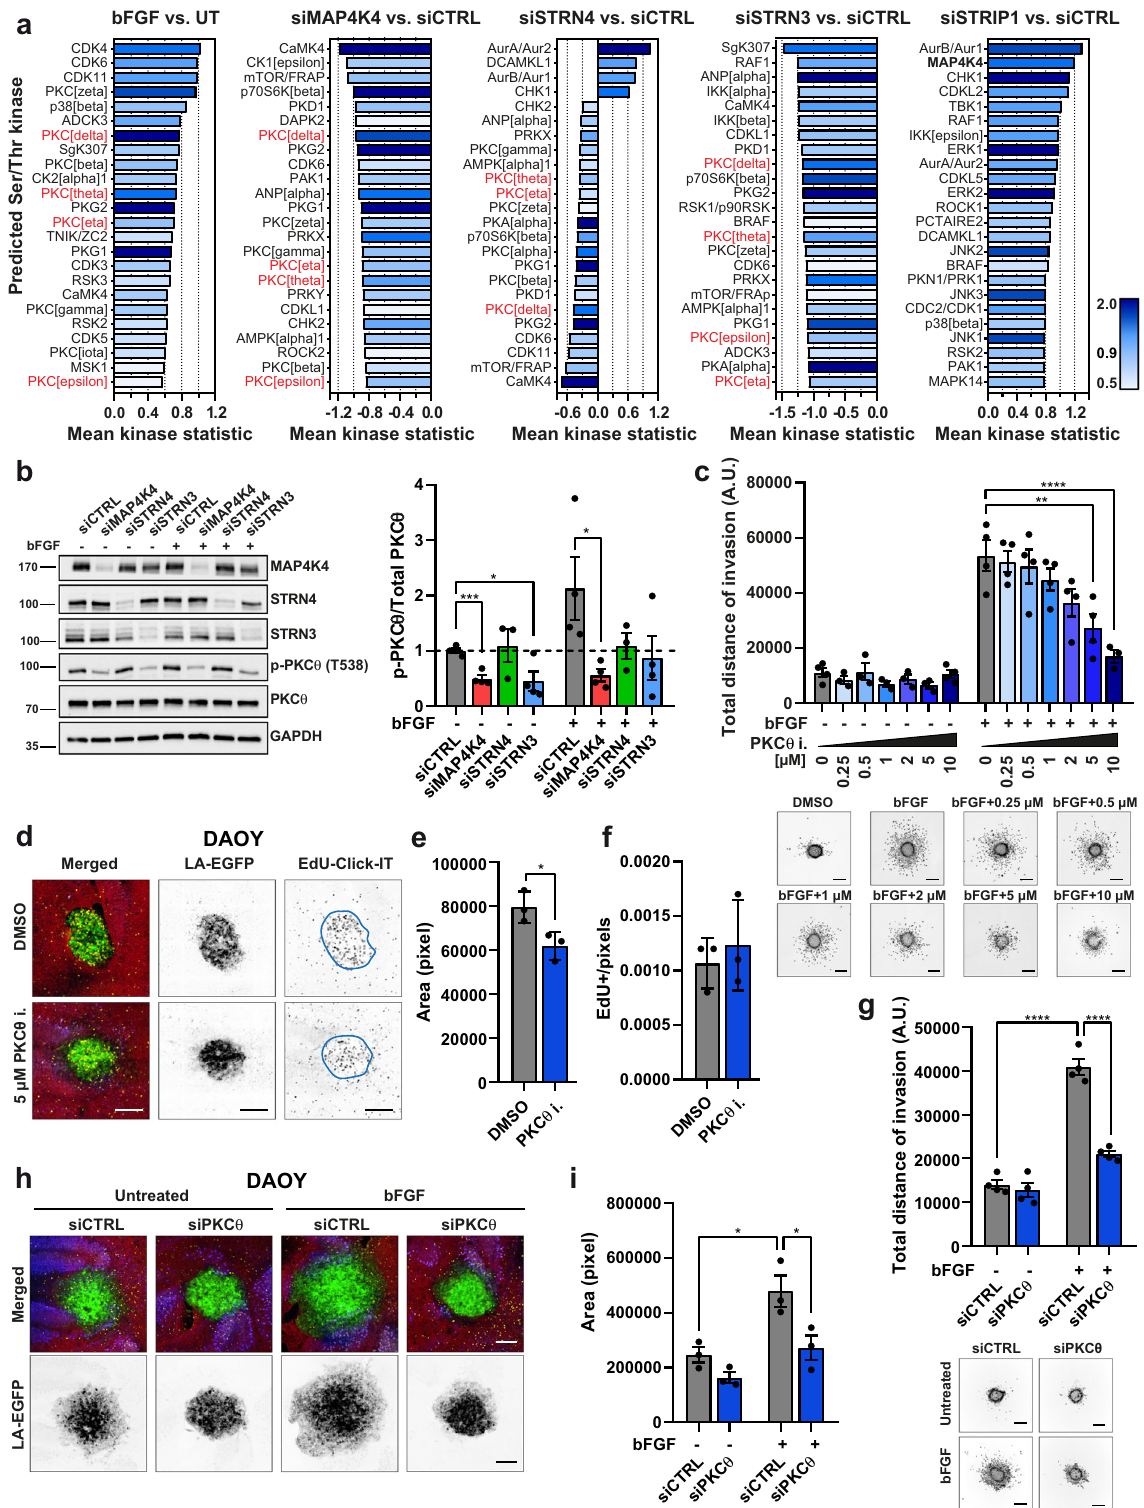
MAP4K4 kinase activity signature after STRIP1 depletion further supports the notion of an antagonizing function of STRIP1 towards MAP4K4. However, the lack of a clear phenotype after STRIP1 depletion also indicates only a minor contribution to migration and growth control in MB tumor cells. STRIP1 depletion has been associated with a contractile motility mode, supporting migration in con fi ned, stiff spaces 63 . Rounded,